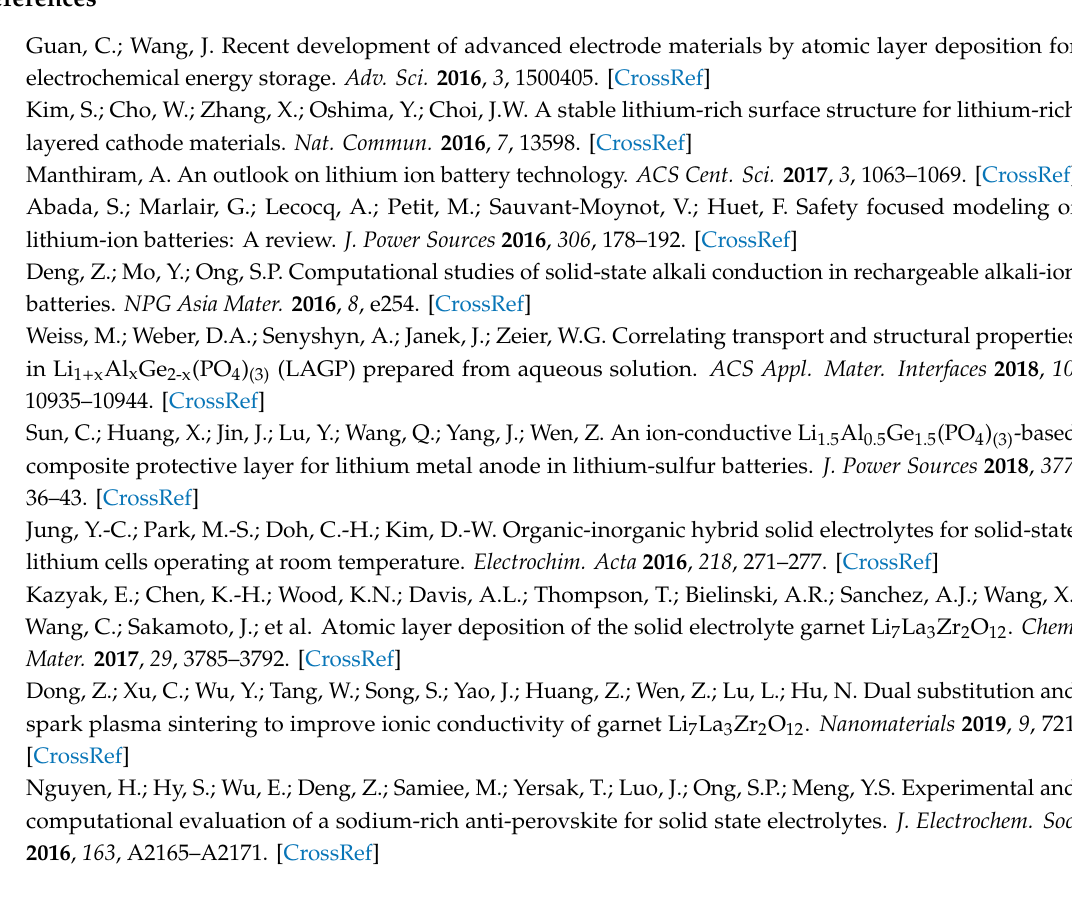
Figure S1: Low-magnification SEM images of SPS pellets sintered for 2 min at di ff erent temperatures of (a) 650 ◦ C, (b) 700 ◦ C, and (c) 750 ◦